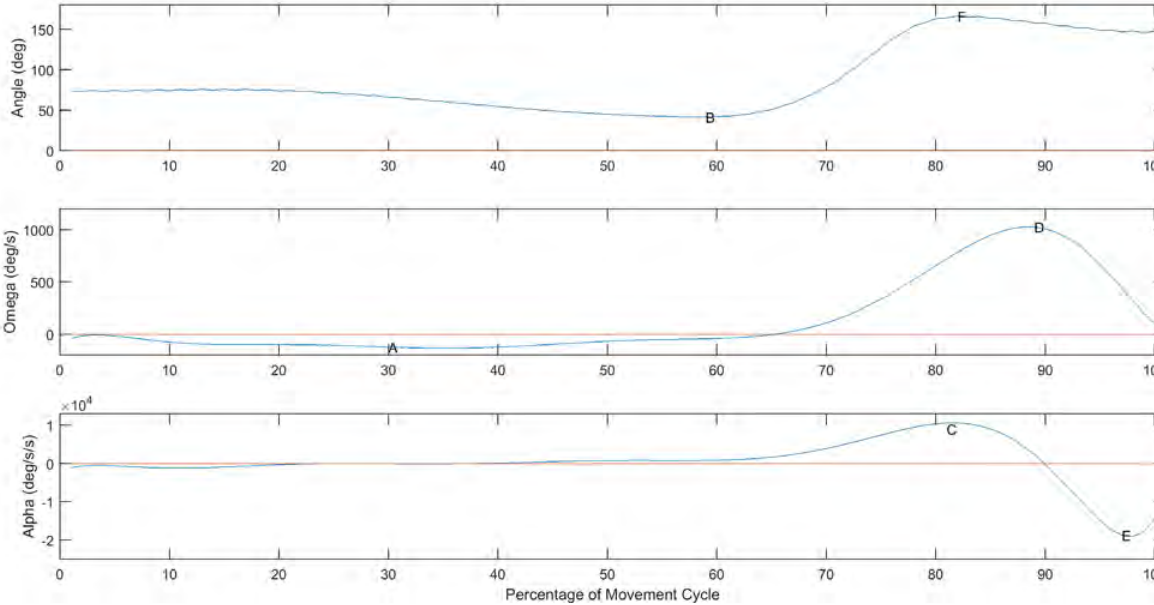
Figure 2. From top to down, elbow angle, angular acceleration and angular velocity of elbow in which peak and land of each plot determined landmarks